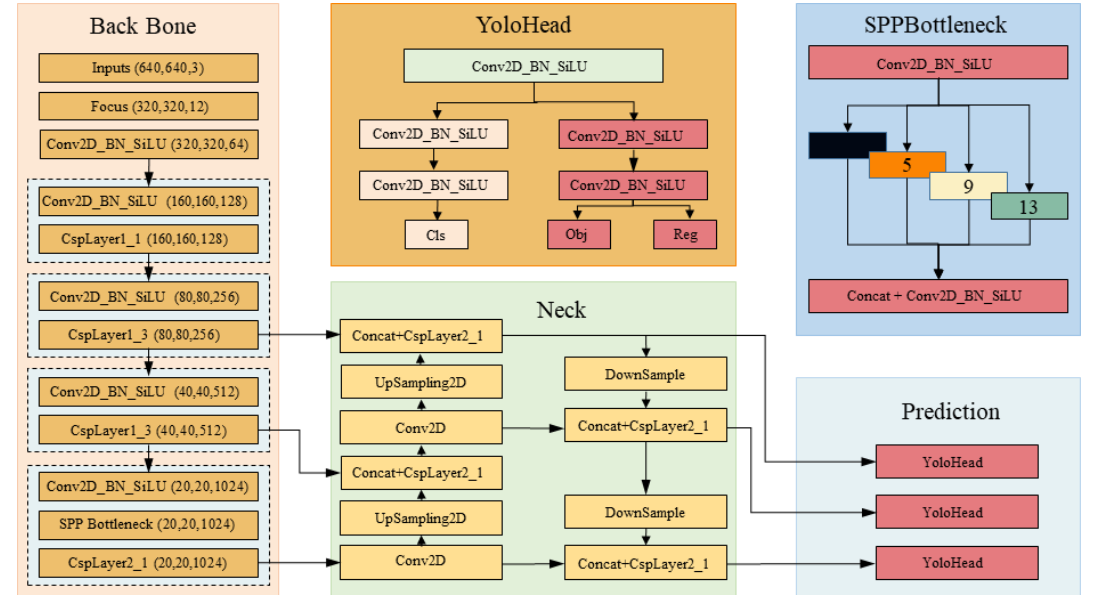
Figure 2. YOLOX network